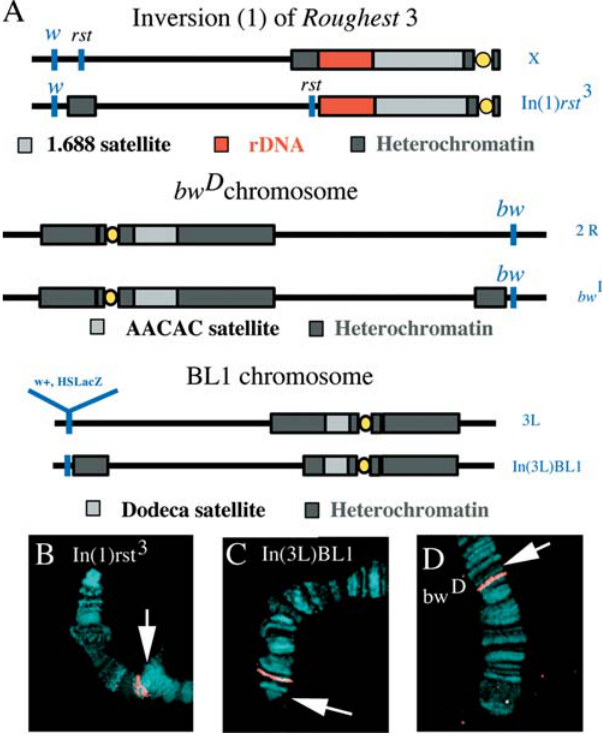
Figure 9. Variegating Lines and Probes Used in This Study Variegating lines were used for three different chromosomes, each variegating for a different gene. For full details see Materials and Methods. (A) Diagram of each line showing approximate breakpoints and locations of variegating genes. FISH probes were made from P1 clones covering each gene and from heterochromatic sequences unique to each chromosome (see Materials and Methods). (B–D) FISH probes for each chromosome. FISH probes were hybridized to polytene squashes to show cytological location of each probe. Regions of proximal heterochromatin from inversion and insertion are marked with an arrow. Each chromosome spread is taken from individual experiments. (B) Probe used in experiments for the line In(1) rst 3 . (C) Probe used in experiments for the